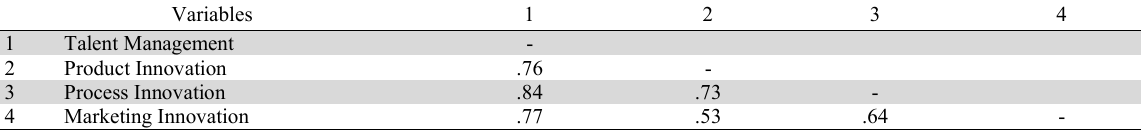
Heterotrait-Monotrait Ratio (HTMT) Variables